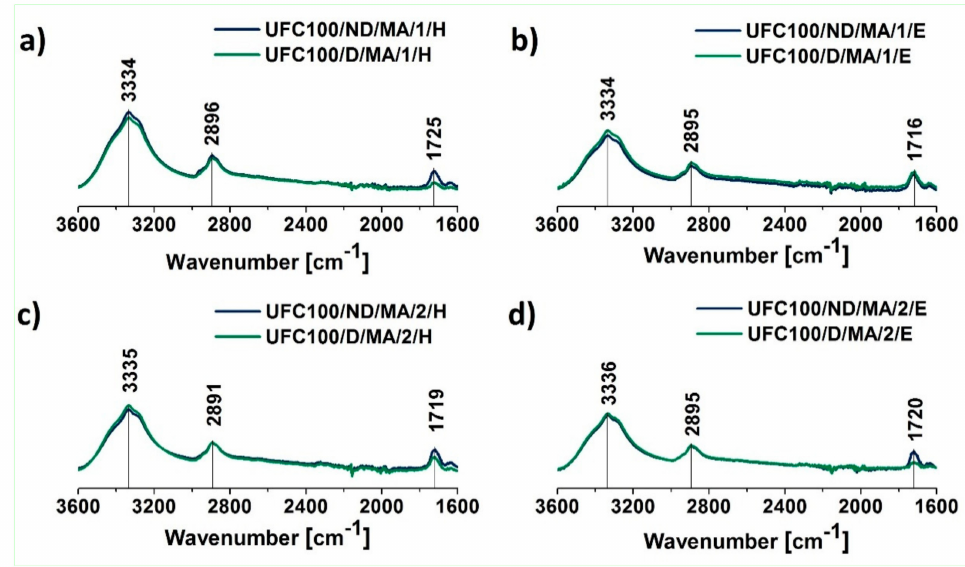
Figure 3. FT-IR spectra of cellulose fibers modified via a hybrid chemical modification: ( a ) solvent exchanged to hexane and then MA treated, ( b ) solvent exchanged to ethanol and then MA treated, ( c